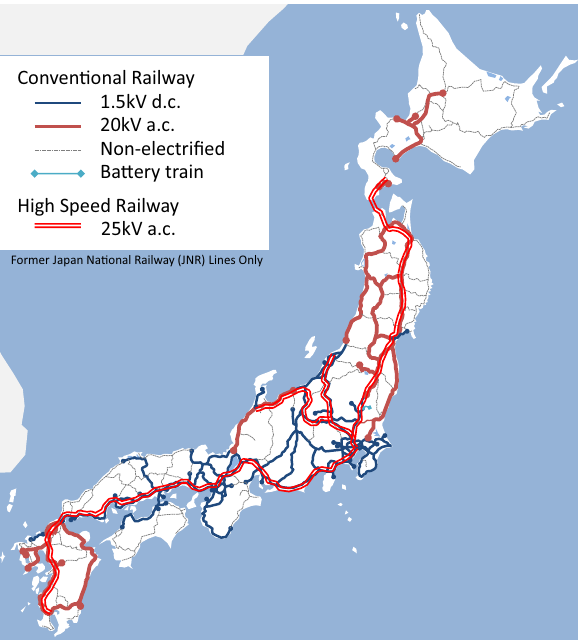
Fig. 5 Electrification of Japanese railway network